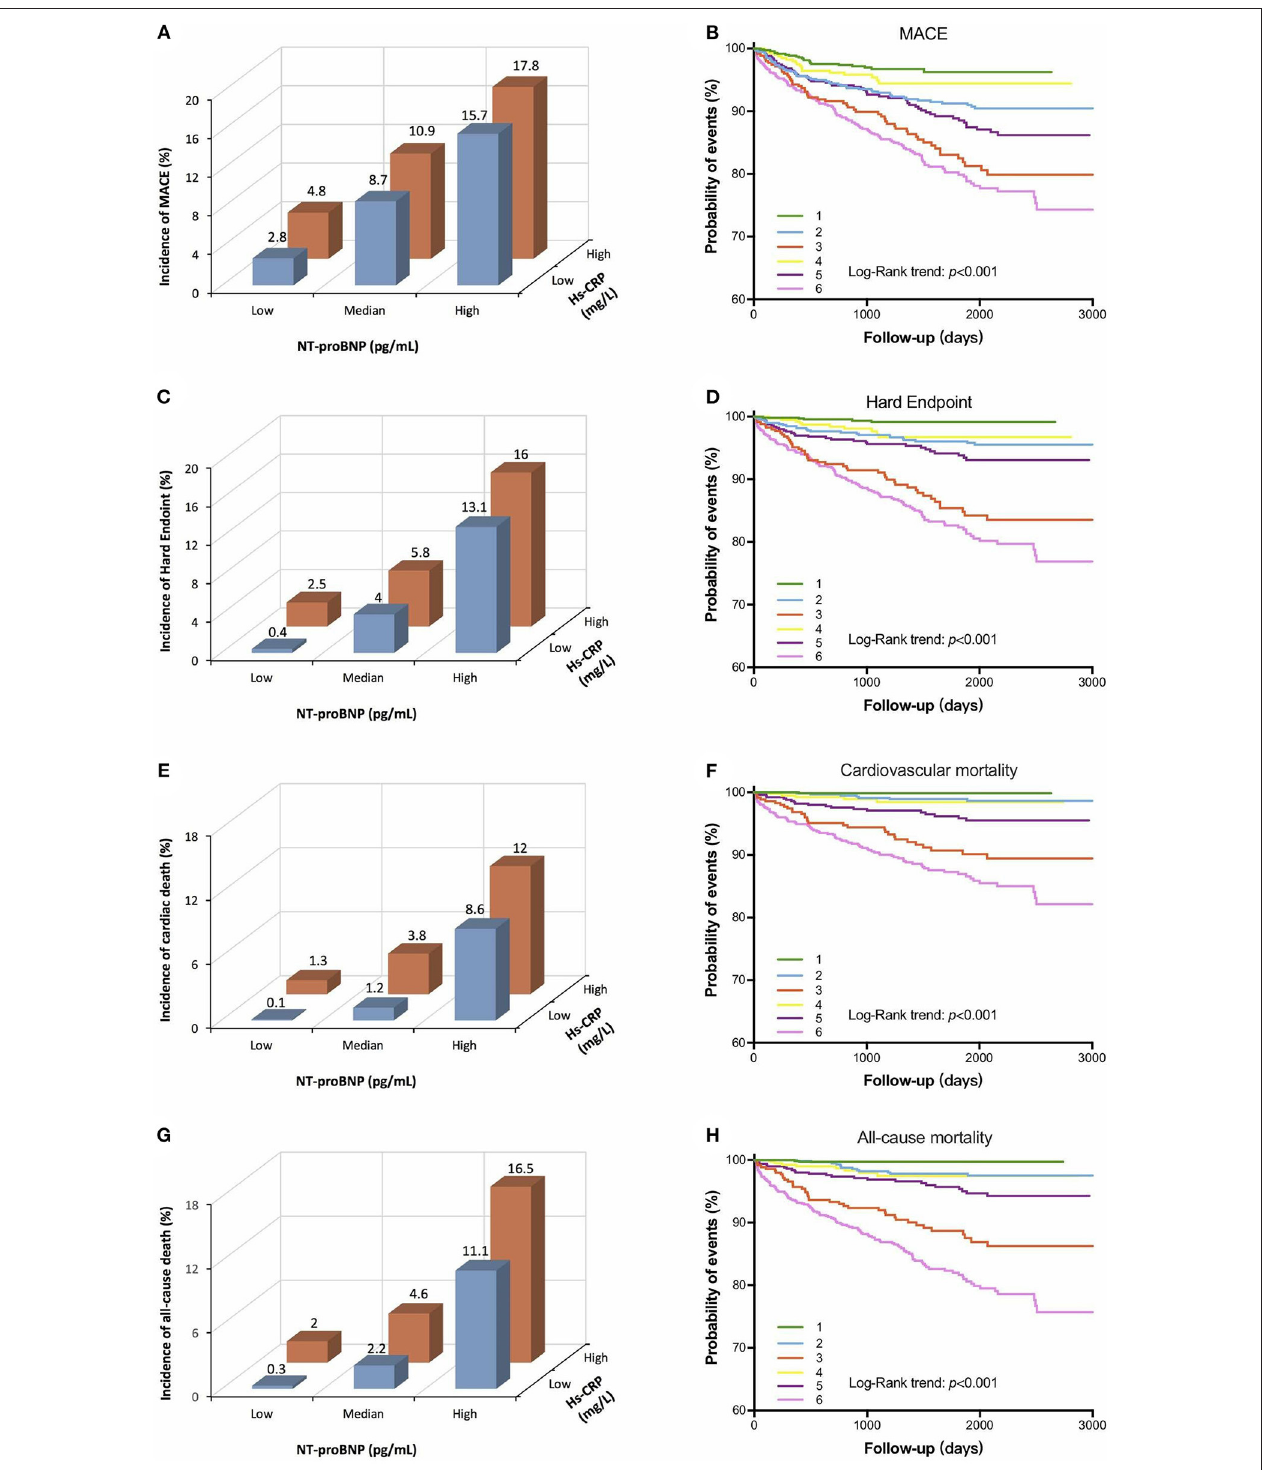
FIGURE 2 | Relationship between cardiovascular markers and cardiovascular events in the follow-up period [left panel: (A,C,E,G) ]. Kaplan-Meier curve for cardiovascular events based on the combinations of NT-proBNP and hs-CRP levels [right panel: (B,D,F,H) ]. 1 indicates low NT-proBNP + low hs-CRP group, 2 indicates median NT-proBNP + low hs-CRP group, 3 indicates high NT-proBNP + low hs-CRP group, 4 indicates low NT-proBNP + high hs-CRP group, 5 indicates median NT-proBNP + high hs-CRP group, 6 indicates high NT-proBNP + high hs-CRP group. NT-proBNP, N-terminal pro-brain natriuretic peptide; hs-CRP, high-sensitivity C-reactive protein; MACE, major adverse cardiovascular